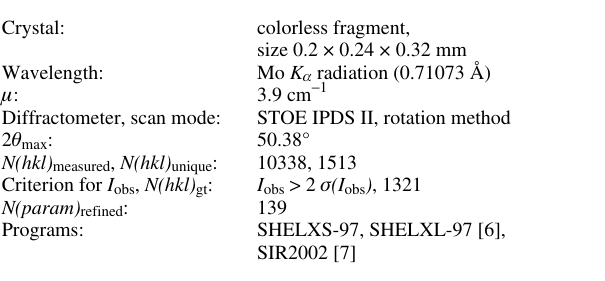
Table 1. Data collection and handling.